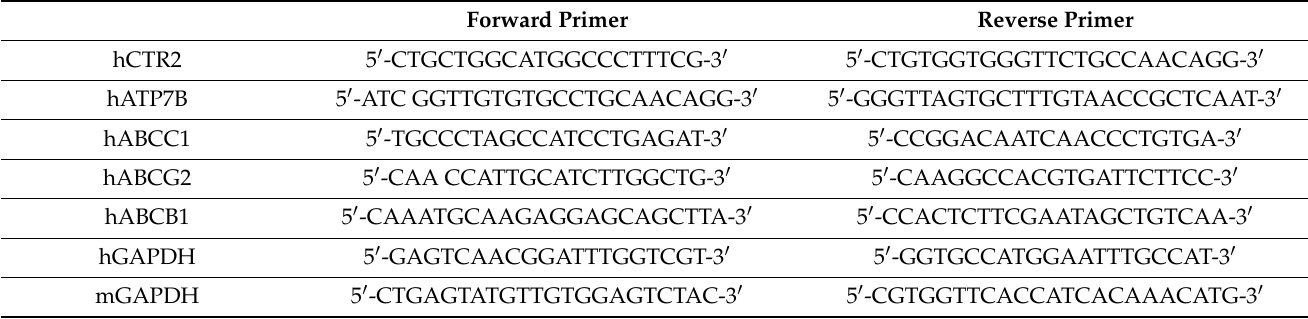
Table 1. Primers used in this